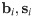
Illustrations of (a) all-atom elastic network models (AAENMs) from the crystal structures, and the coarse-grained elastic network models (CGENMs) from the AAENMs; (b) detailed interactions among the nucleotides (nodes) of the CGENM where nucleotide i interacts with all nucleotides connected by the 11 bold curves; and (c) bi,si, and ti.